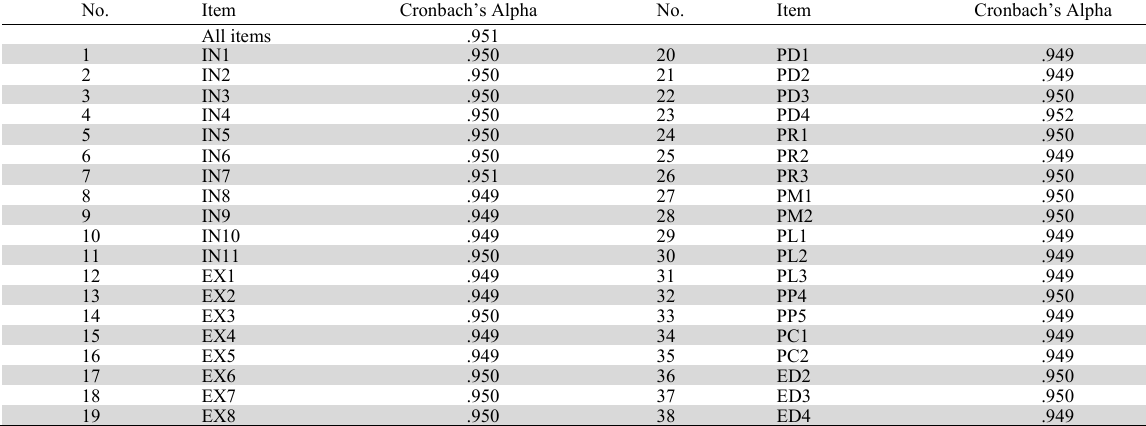
Results of Reliability Test of 38 AIPD